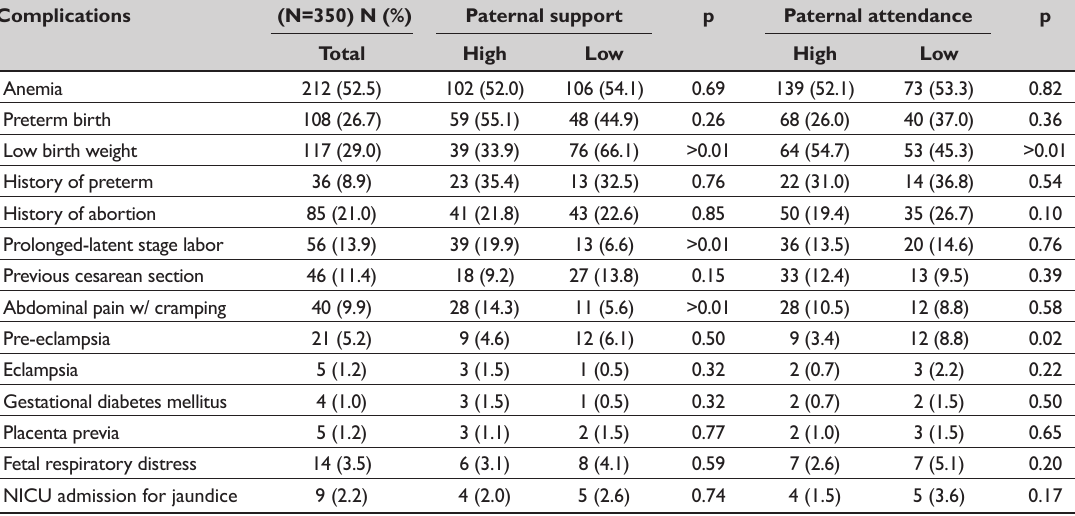
Table 2: Maternal complications in population per paternal involvement Complications